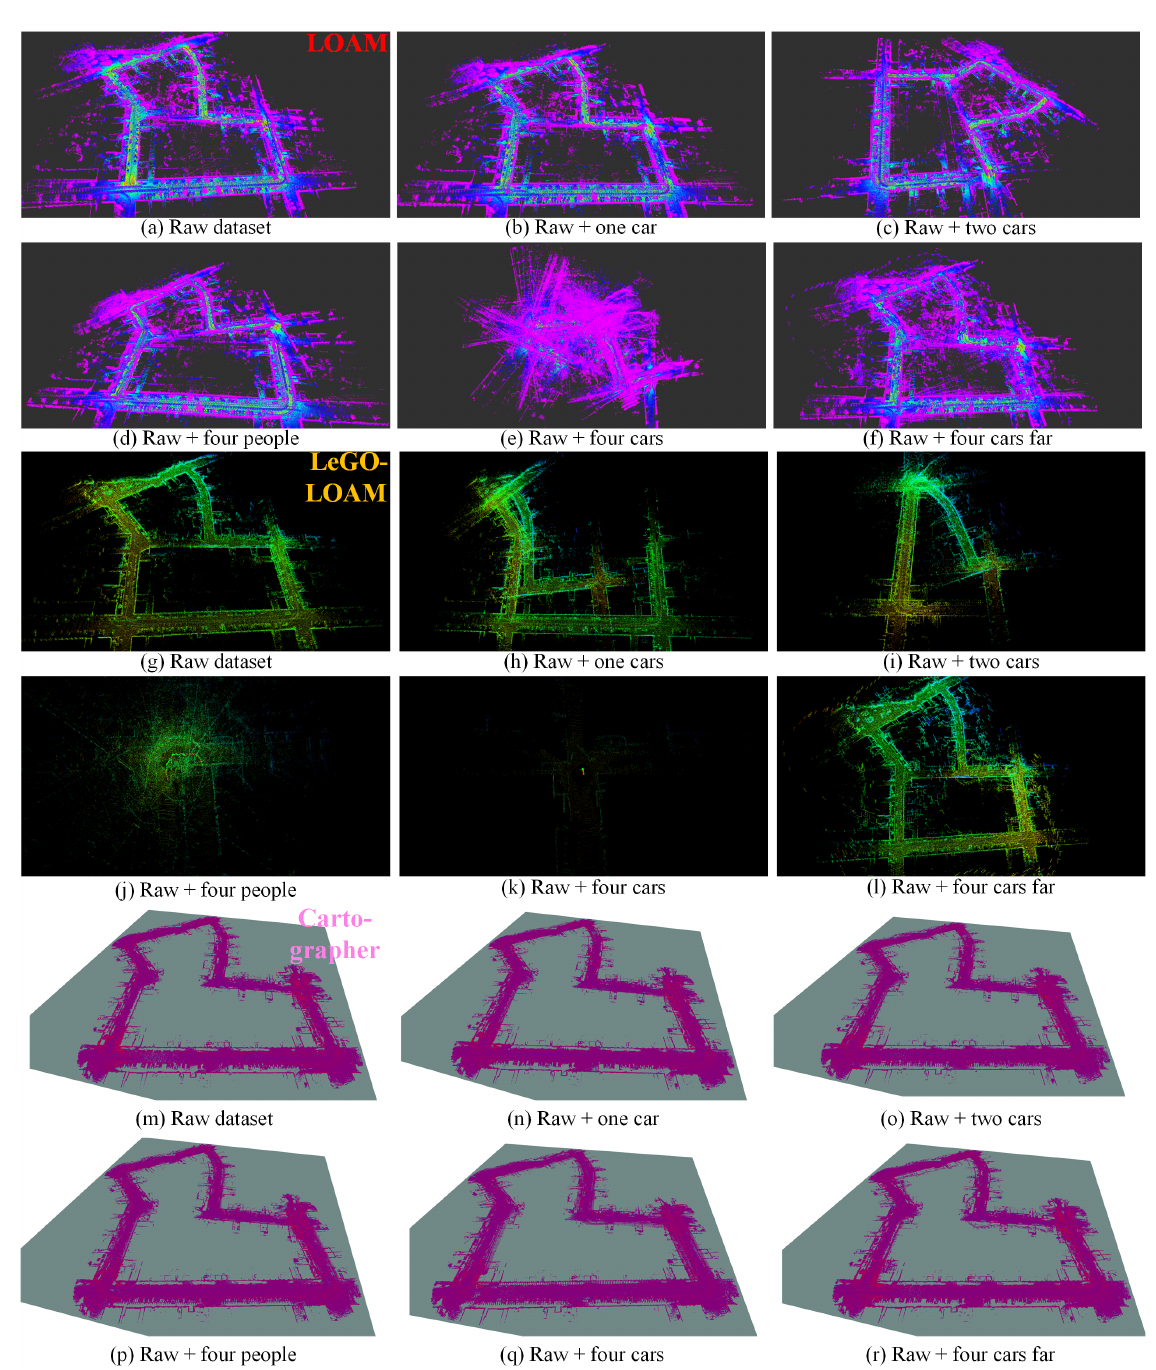
Figure 12. The mapping results (3D view) of LOAM ( a – f ), LeGO-LOAM ( g – l ) and Cartographer ( m – r ) in different simulated scenarios based on KITTI_0027_sim. ( a , g , m ) are the results on the original static data, used as baseline. Please note that in ( c ) estimation error occurs at the beginning, thus results in the deflected map. More dynamic objects result in worse mapping results, and even total failure in some scenarios such as ( e , h , i – k ). In this test Cartographer shows relatively more robust